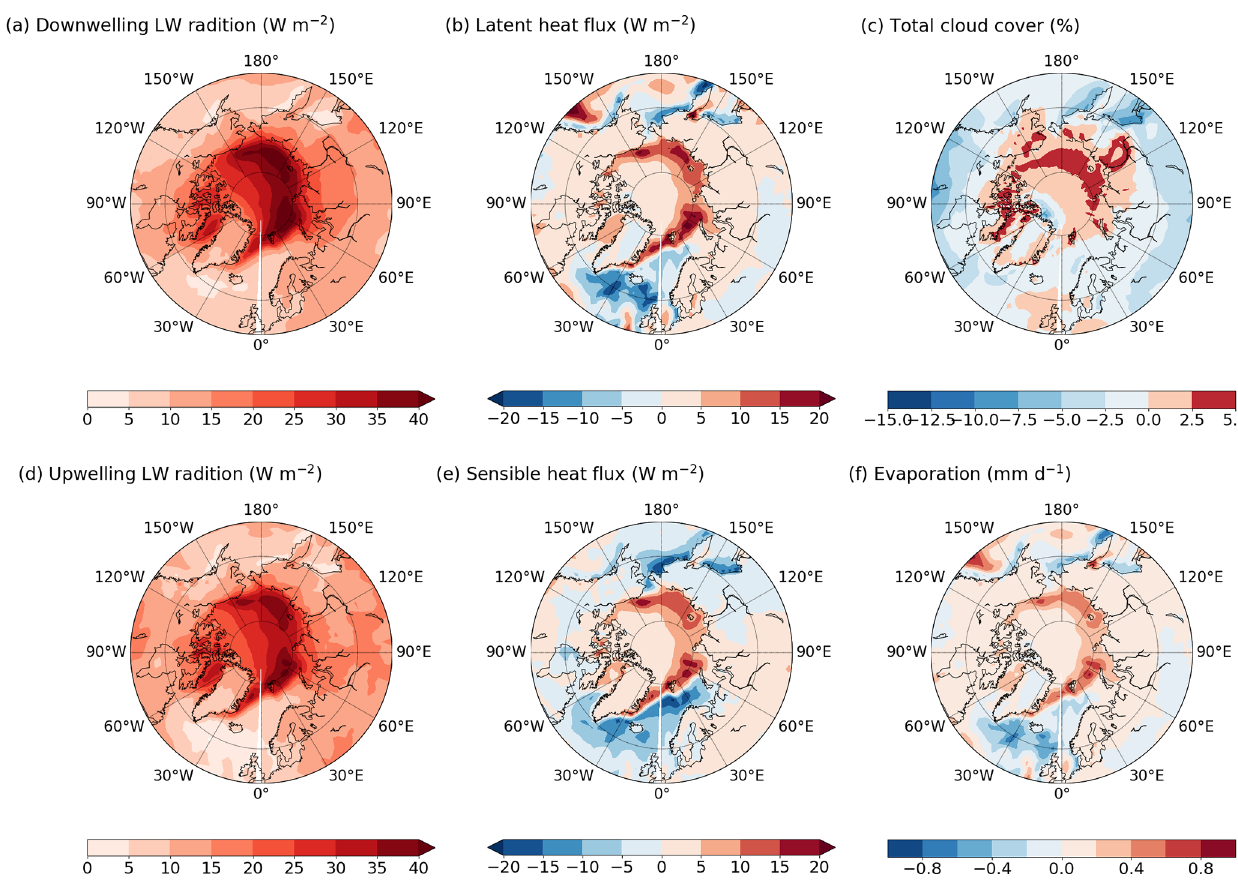
Figure 15. Autumn LIG–PI anomalies of (a) longwave radiation emitted by the atmosphere, (b) latent heat flux, (c) total cloud cover, (d) longwave radiation emitted by the surface, (e) sensible heat fluxes and (f) evaporation. All heat fluxes are in Wm − 2 , the total cloud cover in % and the evaporation in mmd − 1 . Table 2. Seasonal anomalies of the atmospheric heat storage and its components (Wm − 2 ) averaged between 60 and 90 ◦ N.